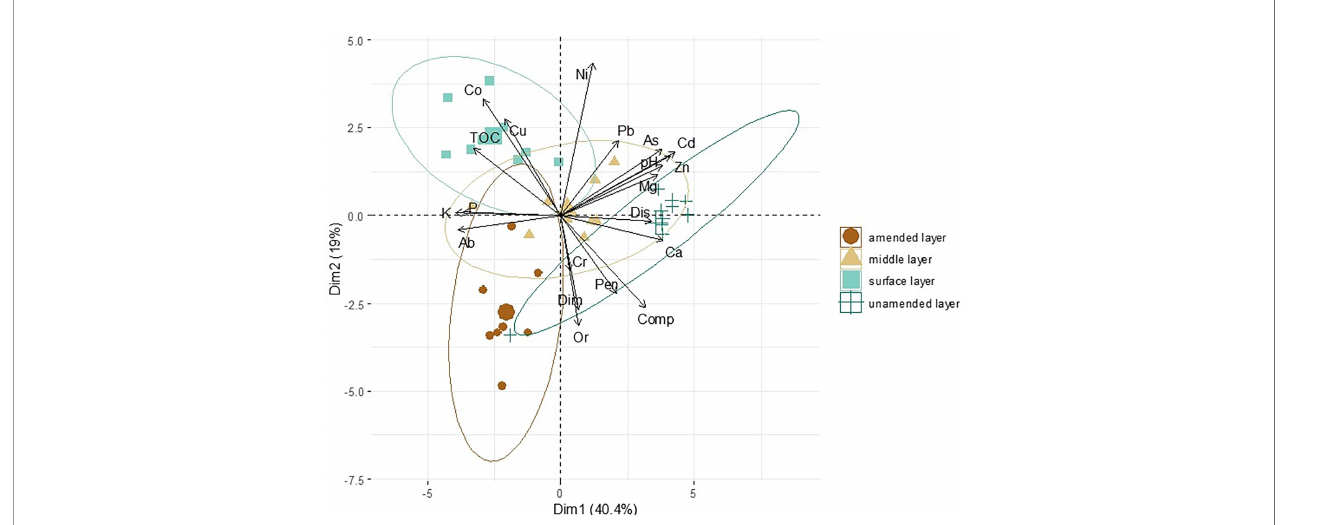
FIGURE 4 | Principal coordinate analysis (PCoA) of root parameters according to the physicochemical characteristics of tailing soil (Ab: abundance of roots, Dim: dimension of roots, Dis: distribution of roots, Or: orientation of roots, Pen: penetration of roots, and Comp: compactness of